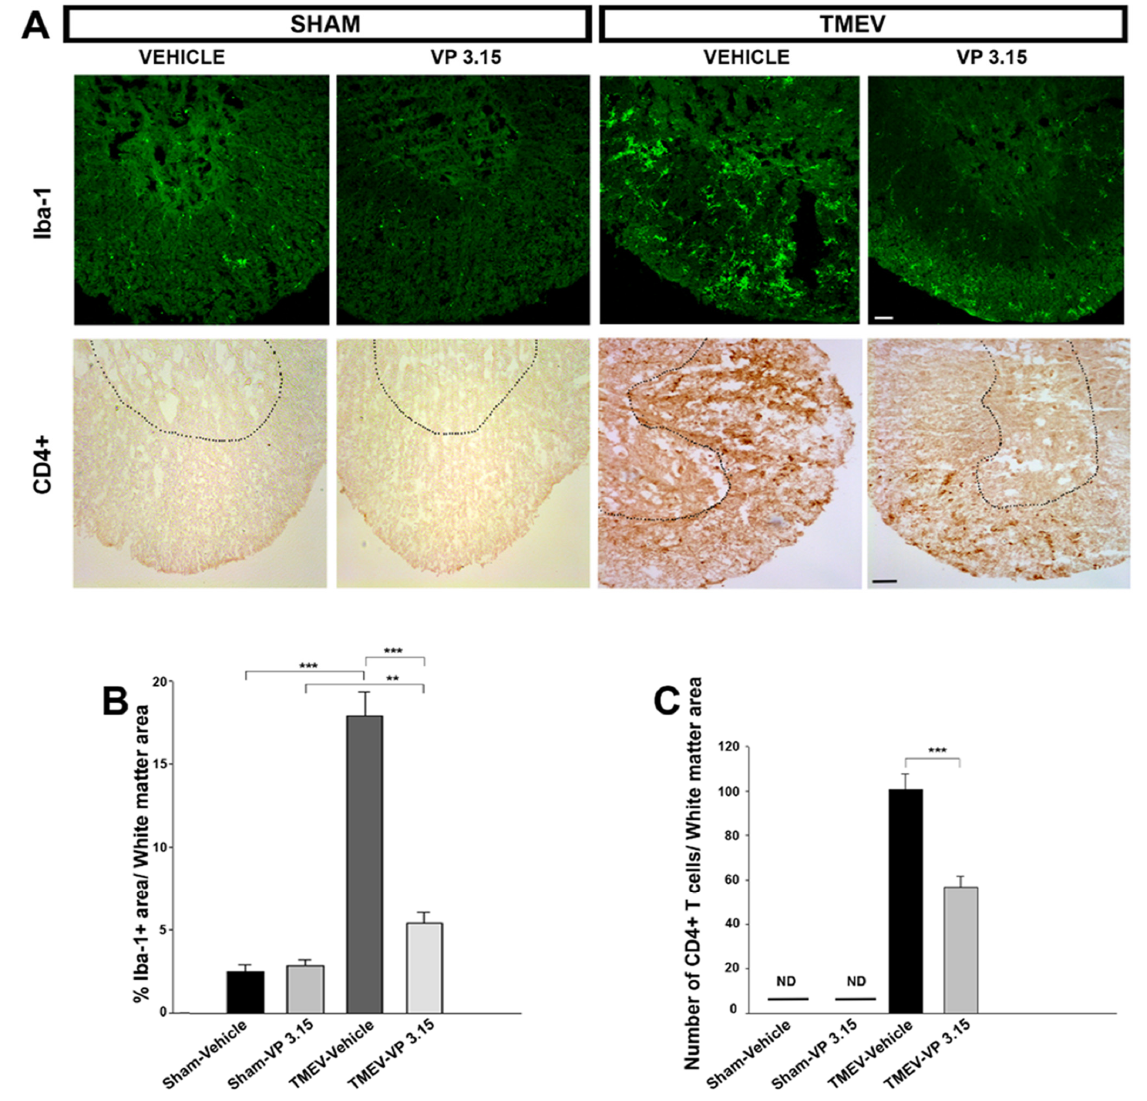
Figure 2. Treatment with VP3.15 significantly reduces Iba-1 staining and infiltration of CD4 + T lymphocytes. ( A ): Panoramic views of the spinal cord labeled for Iba-1 + (green) and stained to visualize CD4 + T-cells. ( B , C ): Quantification analysis of percentage of area stained by Iba-1 + ( B ) and number of CD4 + T-cells of white matter area ( C ). Scale bar represents 50 µ m (Iba-1 + ) and 200 µ m (CD4 + T cells). Abbreviations: ND = non-detected. The results of the Student’s t test are expressed as ** p < 0.01; *** p < 0.001. The results of the One-Way Anova indicated significant differences ( p < 0.05) in the percentage of area marked with Iba-1. (at least 5 slices/mice). The sample size was Sham-Vehicle = 7, Sham-VP3.15 = 4, TMEV-Vehicle = 7, TMEV-VP3.15 =